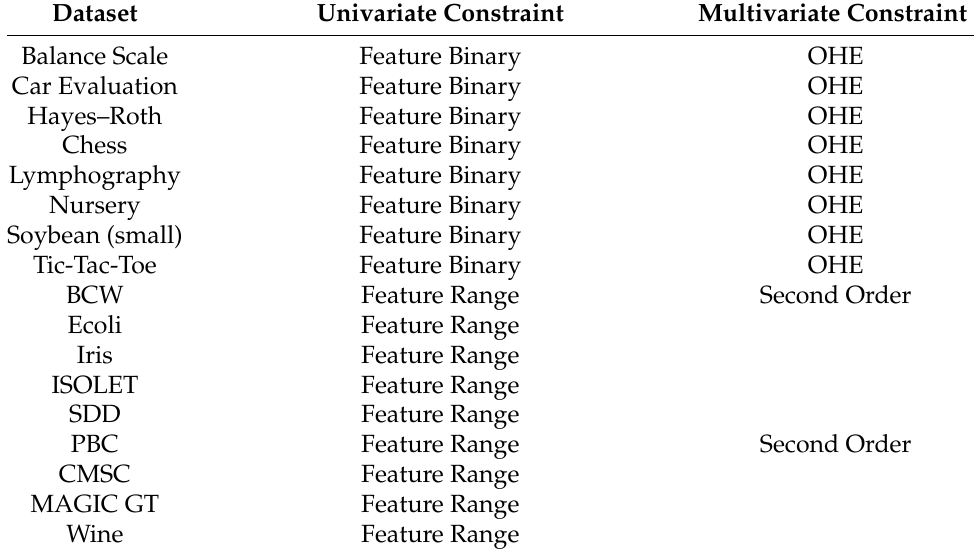
Table A2. Description of constraint types for each dataset. For univariate constraints, Feature Range sets a continuous range where a variable can be changed, Feature Binary allows some features to assume only 0.0 or 1.0. For multivariate constraints, the Second Order describe one or more features that have a second order degree relationship between them, and OHE describes the activation rule of one-hot